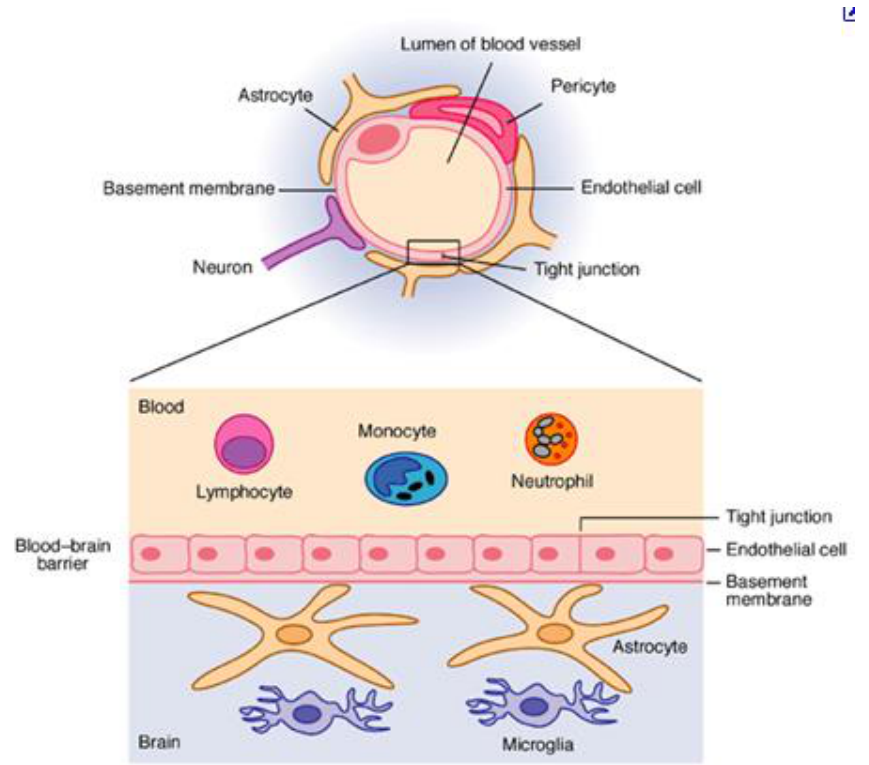
Fig. 1. The Blood-Brain Barrier. (Adapted from Expert Reviews in Molecular Medicine, 2003